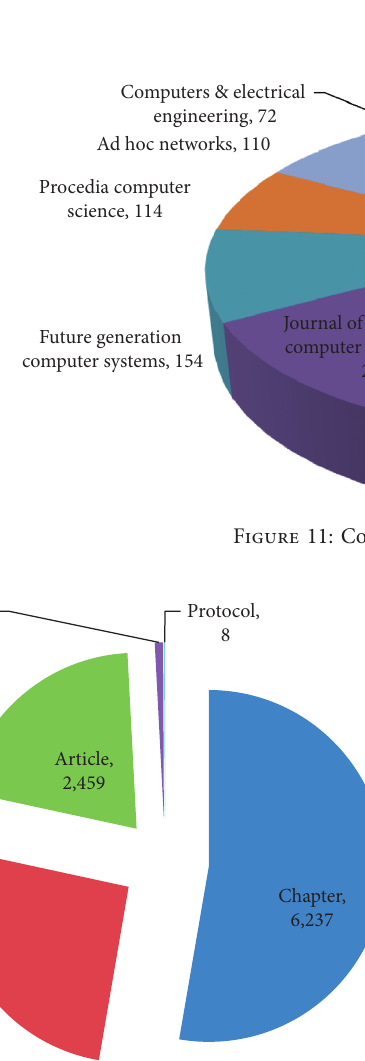
Figure 12: Content type and number of papers.